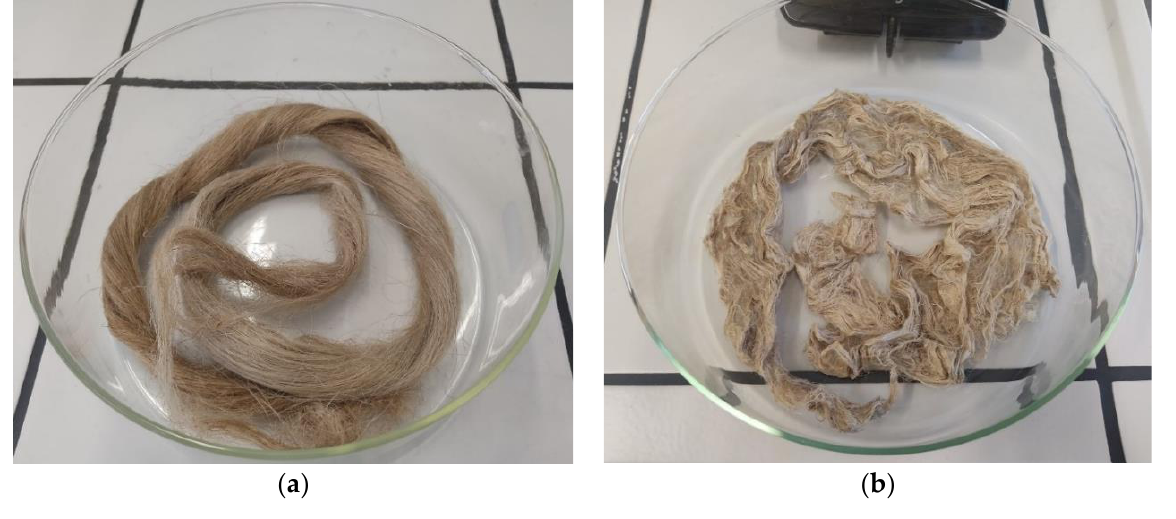
Figure 4. Untreated flax ( a ) and treated flax ( b ).